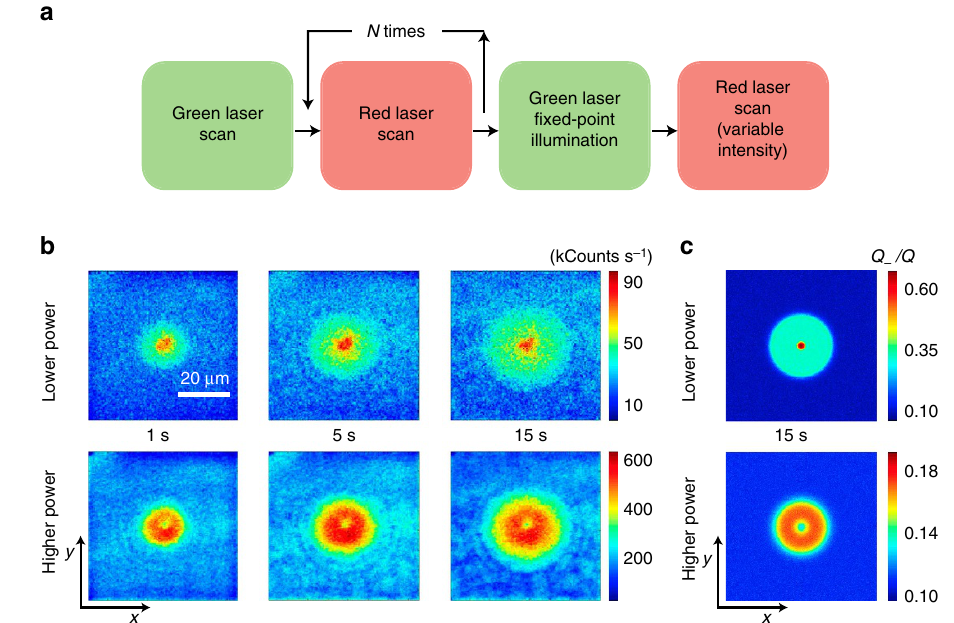
Figure 3 | Mapping NV (cid:2) patterns from fixed-point green-light excitation. ( a ) On initializing the area via a strong green laser scan, we repeatedly scan the red beam to bleach the system fluorescence. We then point the green laser beam to a fixed point and illuminate for a fixed time interval t G , to finally take a fluorescence image by scanning the red beam. ( b ) Fluorescence images on a readout scan in an area around the point of green illumination ( B 1 m m diameter spot approximately at the centre). From left to right, the time t G of green laser illumination is 1s, 5s, and 15s, respectively. Throughout the upper (lower) row of images, the red laser power during the readout scan is 100 m W (1.5mW); in all cases the green laser power is 1.8mW. All images share the same scale bar in the upper left and have a size of 150 (cid:5) 150 pixels recorded with an integration time per pixel of 1ms. ( c ) Calculated NV (cid:2) distribution taking into account the effect of the red laser beam during scanning (100 m W for the top image and 1.5mW for the lower image). The scale bar and axes labels in b also apply to all images in b and c . All parameters as listed in Supplementary Table